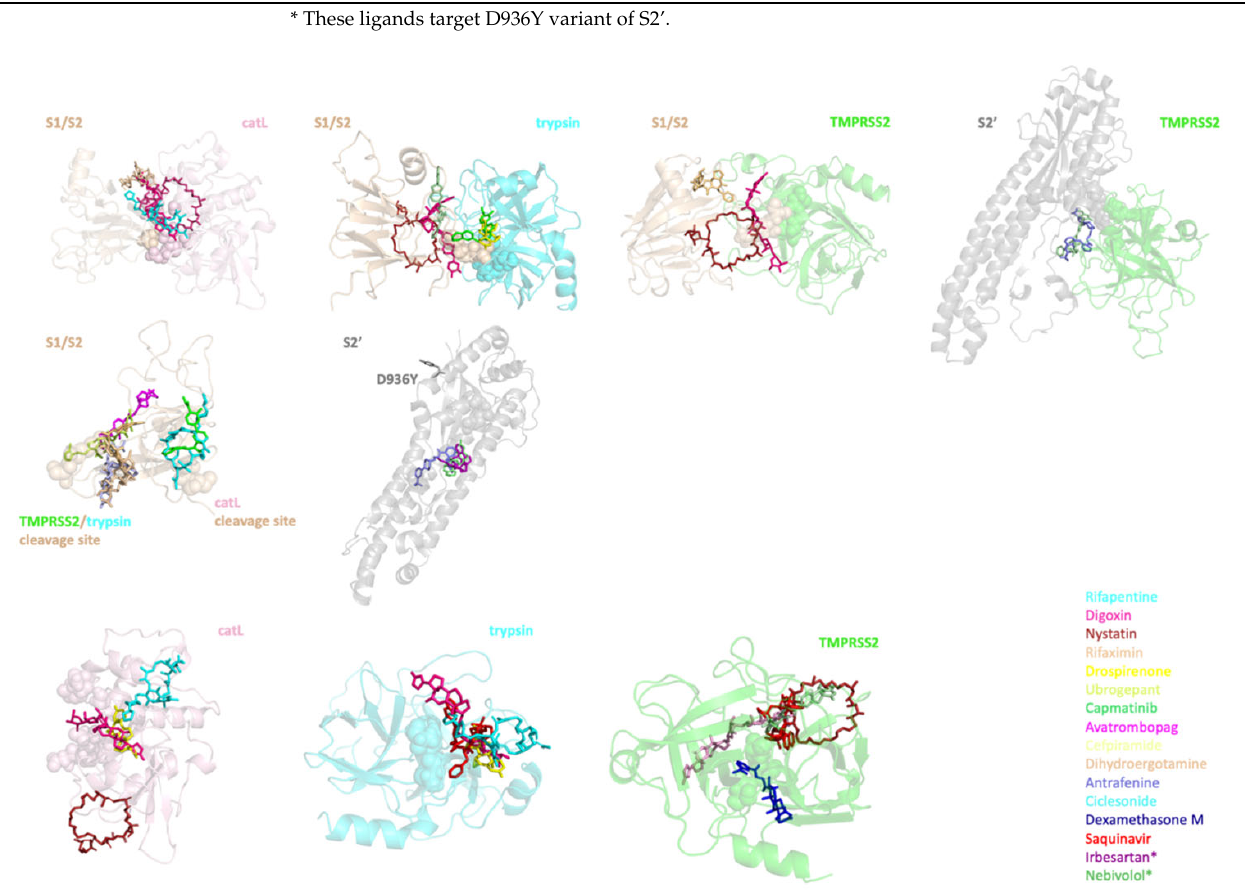
Figure 5. The ligands in complex with their targets. The initial configurations of the ligands bound to their targets are shown in stick representation. Their color-coded list can be seen on the right. Catalytic sites of the proteases and cleavage sites of the S protein are shown with spheres. Two different cleavage sites on the S1/S2 region of the S protein are labeled on the figure. * Irbesartan and Nebivolol are specific to D936Y variant of the S protein.